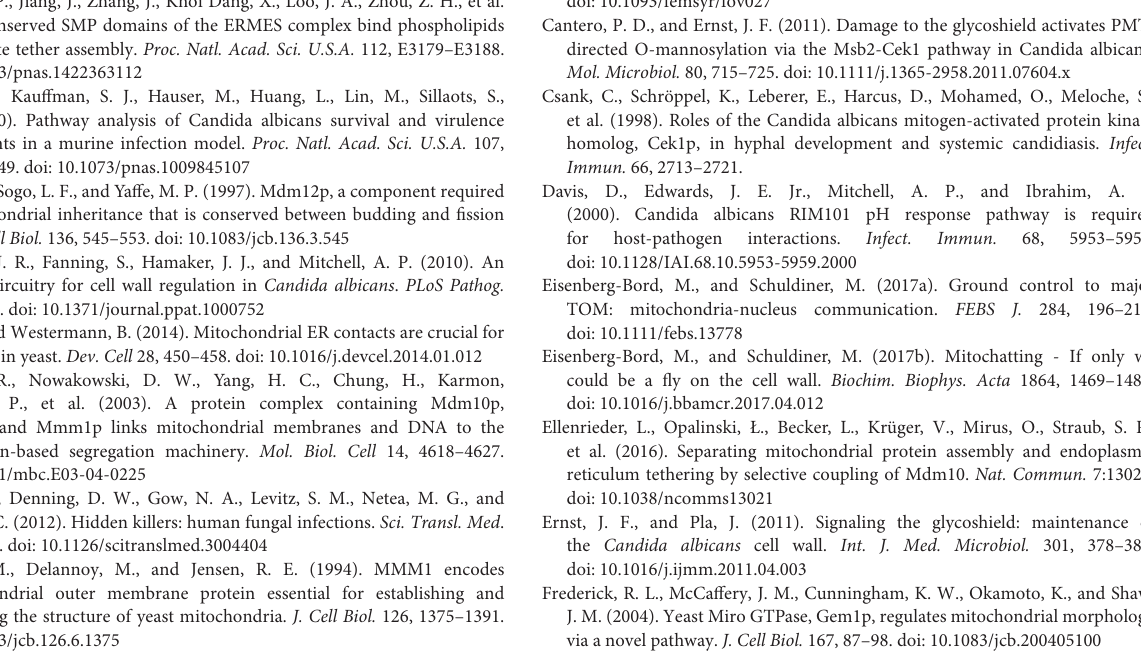
Figure S3 | Activation of the Cek1 signaling pathway in the gem1 1 / 1 mutant in response to cell wall stress. Cells were grown as described in Figure 3A , and phospho-Cek1 and actin detected as described in the section Materials and Methods. Five independent experiments (Exp1-Exp5) were performed. One is shown in Figure 3A and the other four are shown here. These experiments were used for quantification of the relative phospho-Cek1/Act1 levels at the 120min post caspofugin treatment, and the quantification data is shown in Figure 3B . Exp6 was not used for quantification due to no detectable phospho-Cek1 band in the gem1 1 / 1 mutant. The control strain in this experiment was the completemented strain ( + GEM1 ). Table S1 | Primers used in this